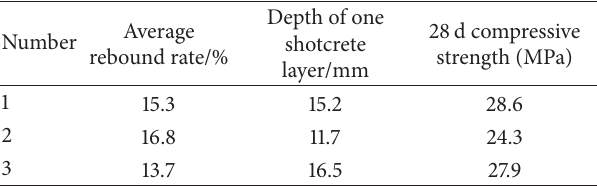
Table 5: The shootability comparison of different wet-mix